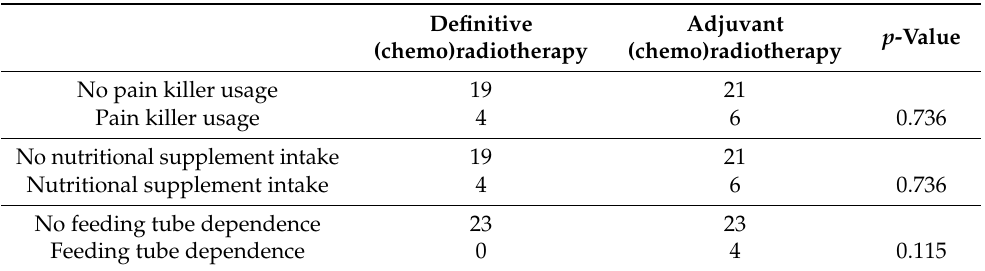
Table 2. Comparison between the definitive and adjuvant (chemo)radiotherapy group in terms of pain killer usage, nutritional supplement intake and feeding tube dependence (within the last week) among surviving elderly HNSCC patients. p -values are obtained from Fisher’s exact